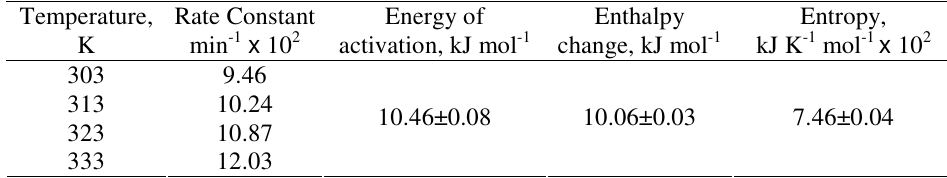
Table 2. Thermodynamic parameter for adsorption of Eu(III) ions on local